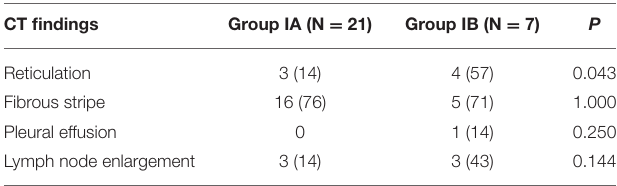
TABLE 4 | CT findings on the last follow-up CT images in patients with traction bronchiectasis. CT